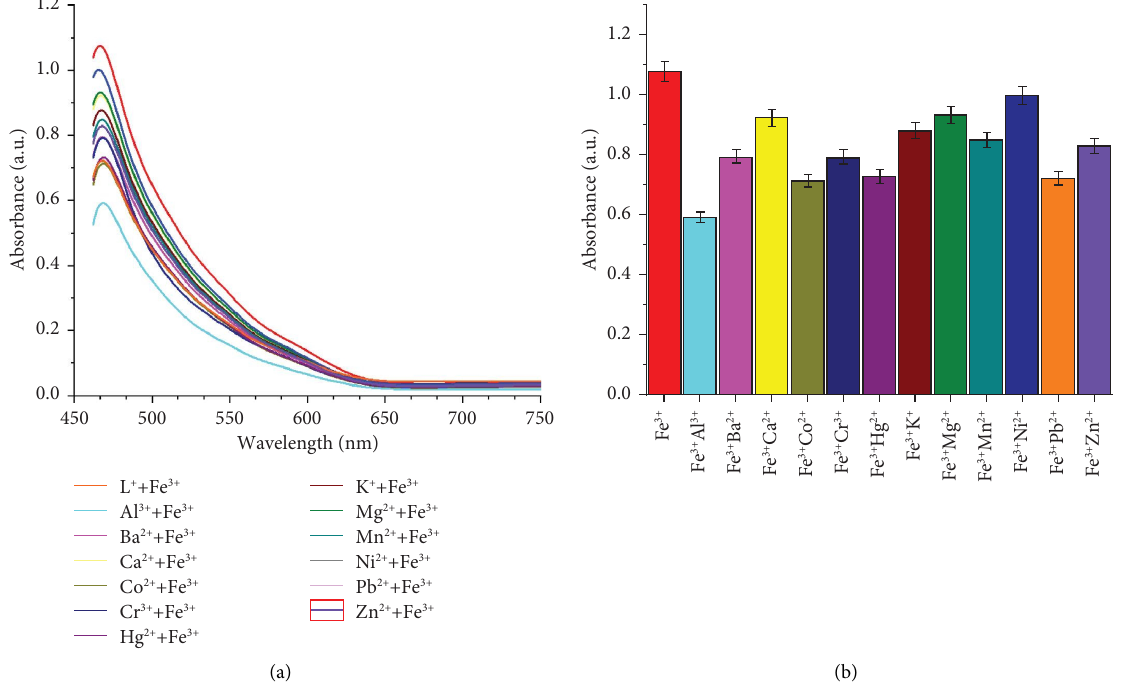
Figure 9: (a, b) Interference studies for the selectivity of the chemosensor SL towards Fe 3+ (70 μ M) in the coexistence of other cationic species (70 μ